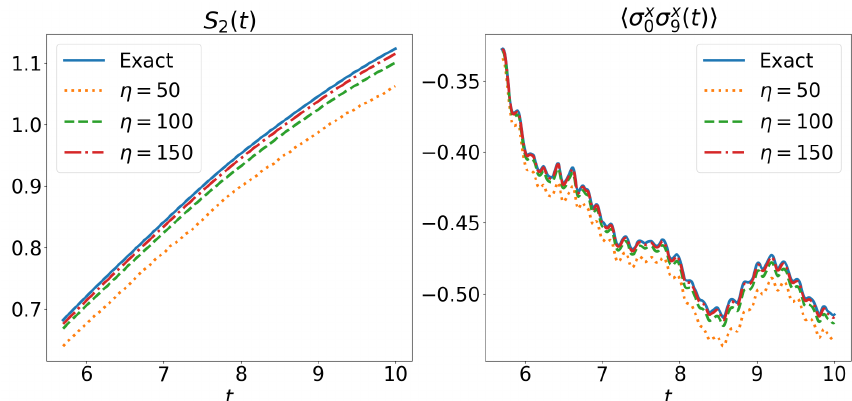
Figure 23: The Z expectation value (left) and the second Rényi entropy S (right) vs. the time t , of the end qubit at the right edge, for plaquettes of identical qubits as in Fig. 22, with the length varying between N = 10 to N = 22, and the pa- rameters given in Eqs. (26)-(32). The relatively long-duration “dip” in 〈 Z 〉 observed with the end qubits of linear chains of different lengths (e.g., in Fig. 4), is not seen with this topology. The simulation for N = 10 is numerically exact, and S seen to increase monotonously in this setup in the initial times, while for the MPO solutions with N > 10 and maximum bond dimension η = 1000, the S ifests an inflection curve in its time dependence at t ≈ 1.7. Marked with shading is the region where these simulations become relatively inaccurate – see the text re- garding indications of simulation breaking.